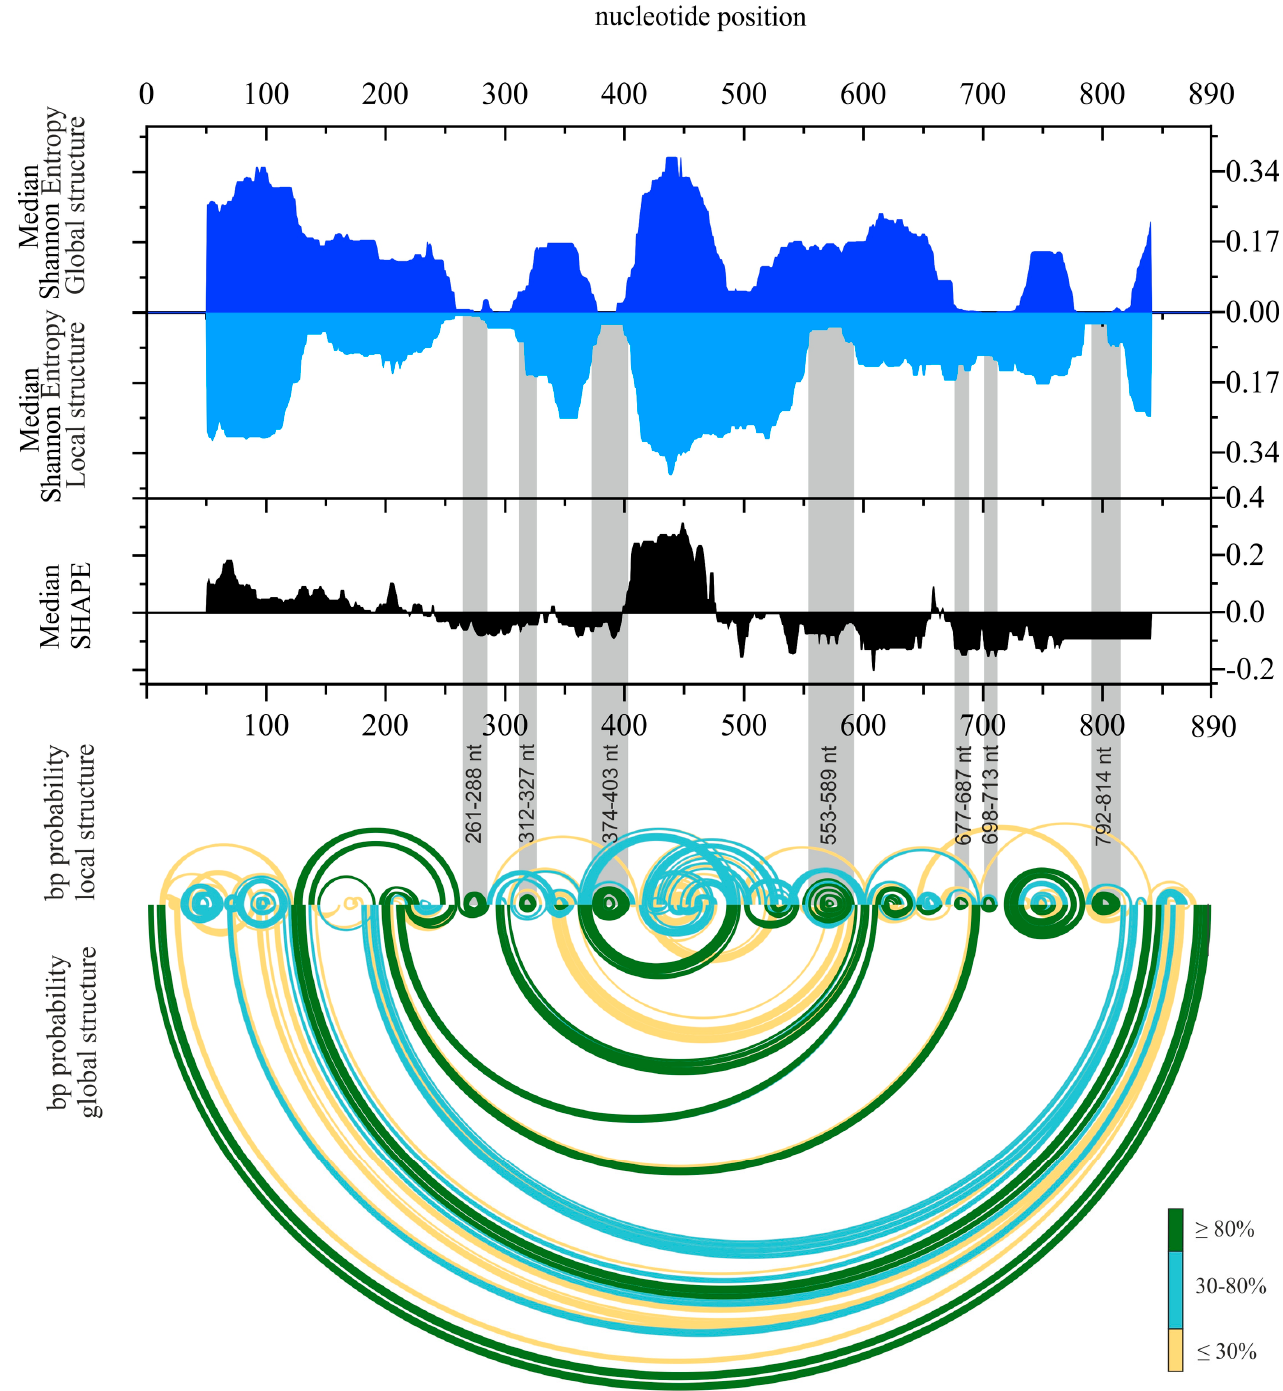
Figure 6. The secondary structure of vRNA8 in cell lysate. Median Shannon entropies of global and local structures were calculated in a centered, sliding 50 nt window. Median SHAPE (1M7) reactivities were calculated in 50 nt window and plotted with respect to global median. Arc plots showing the base-pairing probabilities of predicted local (upper) and global (lower) structures were estimated using the partition function (RNAstructure). Grey shadings indicate the low Shannon entropy/SHAPE reactivity regions of the most probable, well-defined structural motifs predicted in both global and local vRNA8 secondary structures. Calculations for regions of 50 nt of vRNA8 from both ends (Median Shannon, SHAPE) were excluded from visualization. No reactivity data were obtained in regions: 1–38 nt and 818-890 nt (1M7).